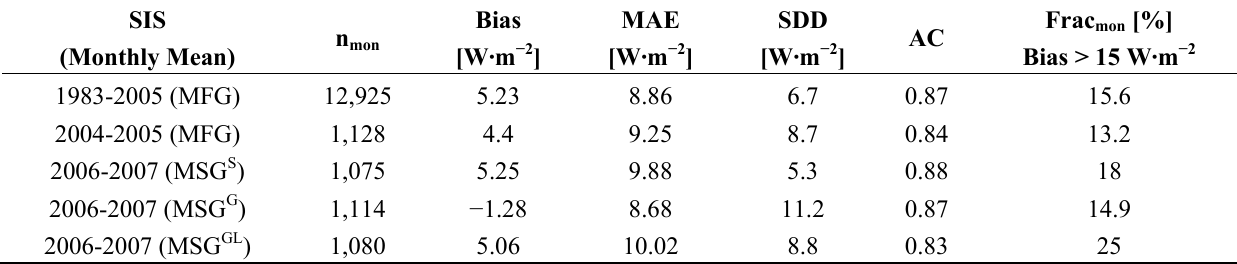
Table 4. Comparison of monthly SIS between CM SAF and GEBA measurements for different time periods and three algorithms used for the extension of the CM SAF series after 2005. Anomalies refer to the period 1983–2005.